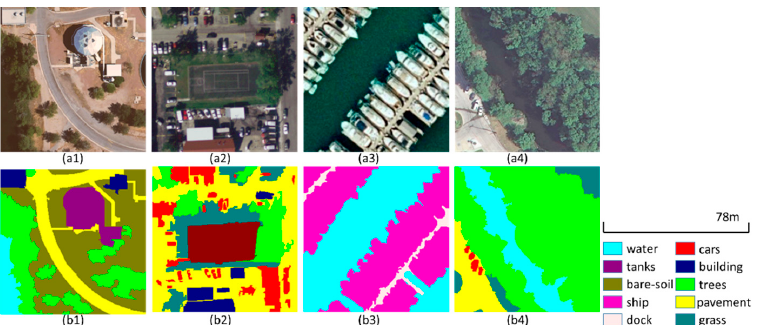
Figure 3. Examples in the public dataset . ( a1 – a4 ) True color images. ( b1 – b4 ) Corresponding